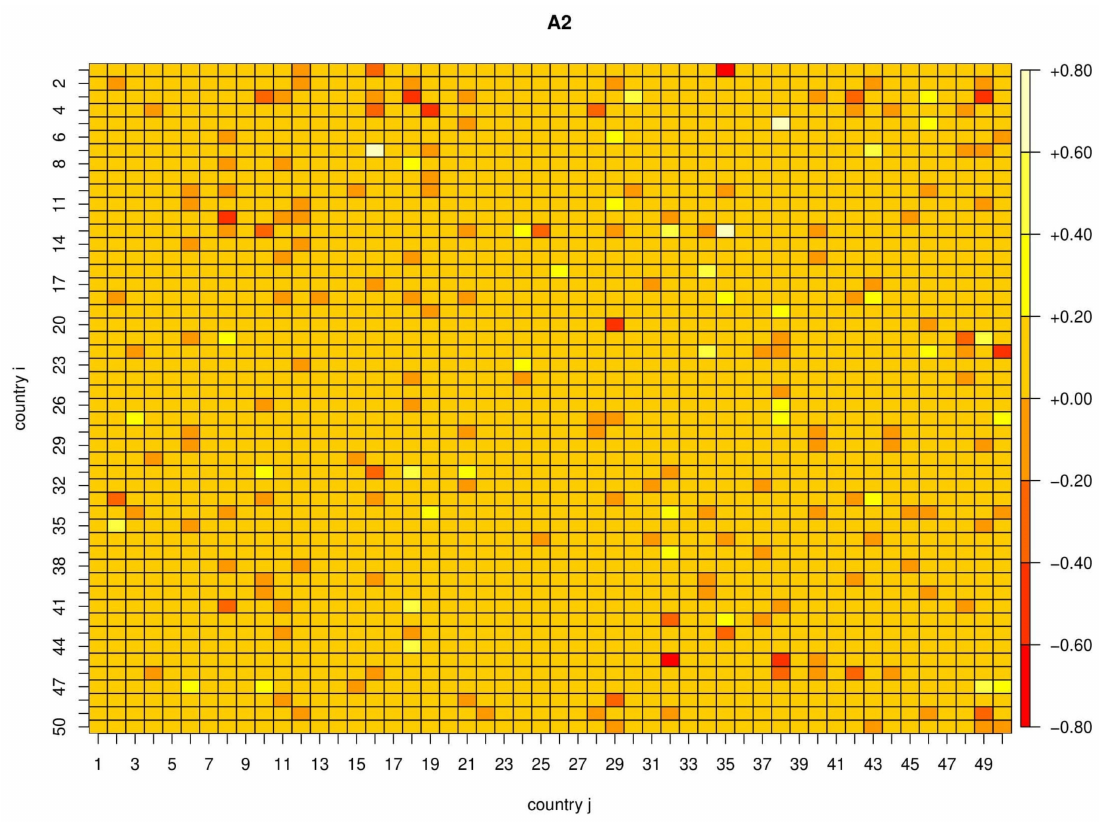
Figure 3. Estimated parameter matrix A 2